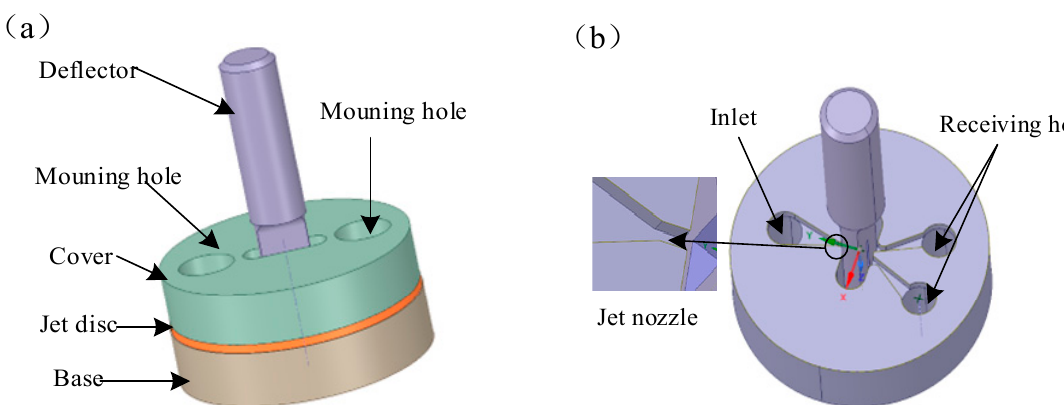
Figure 1. Schematic diagram of the DJSV.